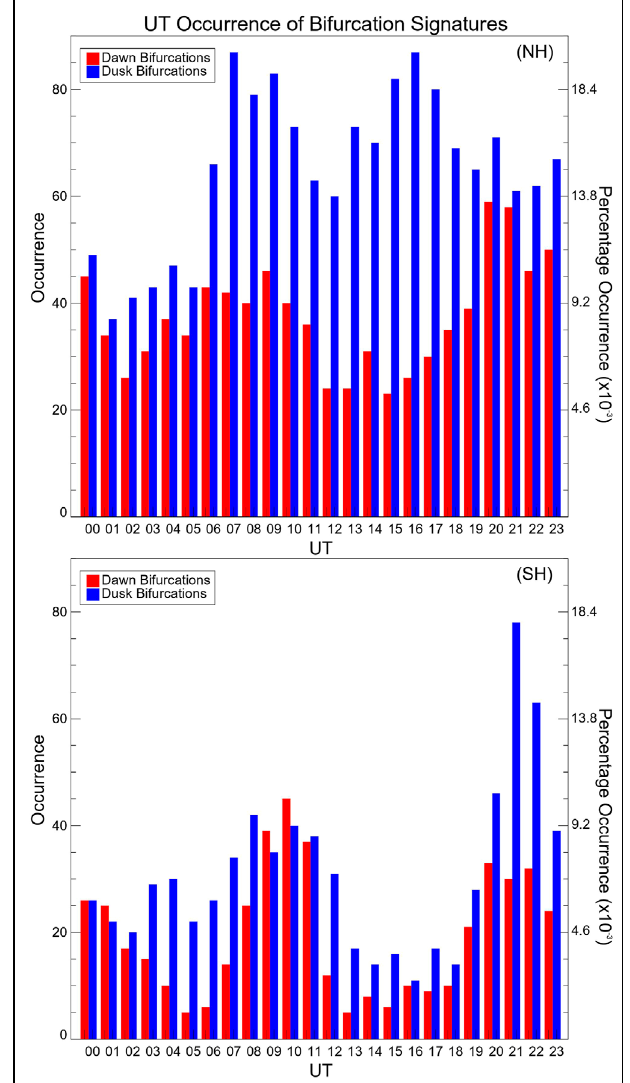
FIGURE 3 | Universal time (UT) occurrence distribution of the bifurcation signatures from 2011 to 2014, in (top) the northern hemisphere and (bottom) the southern hemisphere. The right-hand axis shows the percentage occurrence of the R2Bs. In both plots, the red shows the dawn bifurcations and the blue shows the dusk